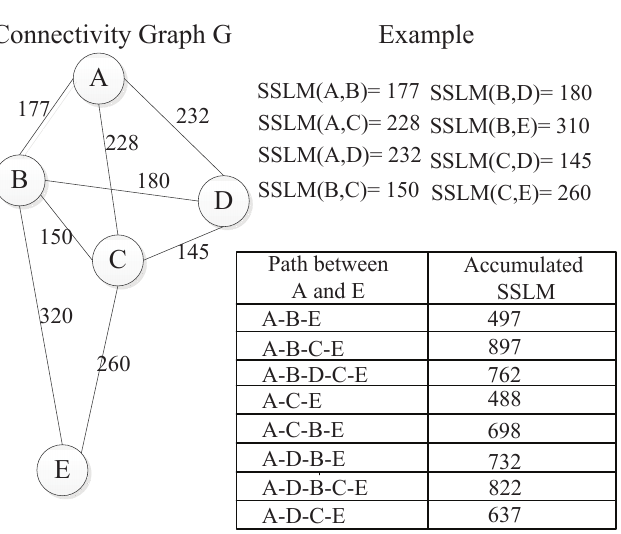
Figure 3. Distance estimation for non-neighboring